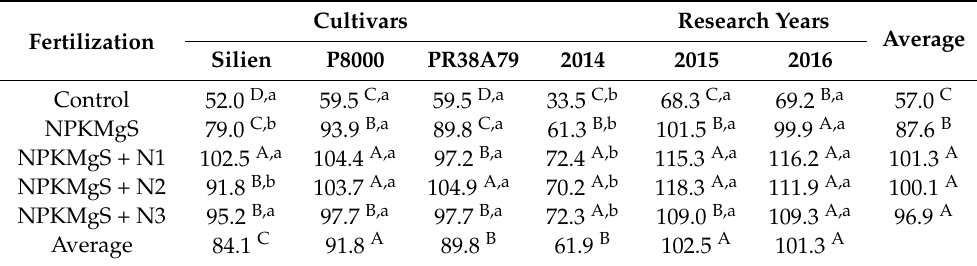
Table 4. The fresh matter yield of maize grown for silage (Mg · ha –1